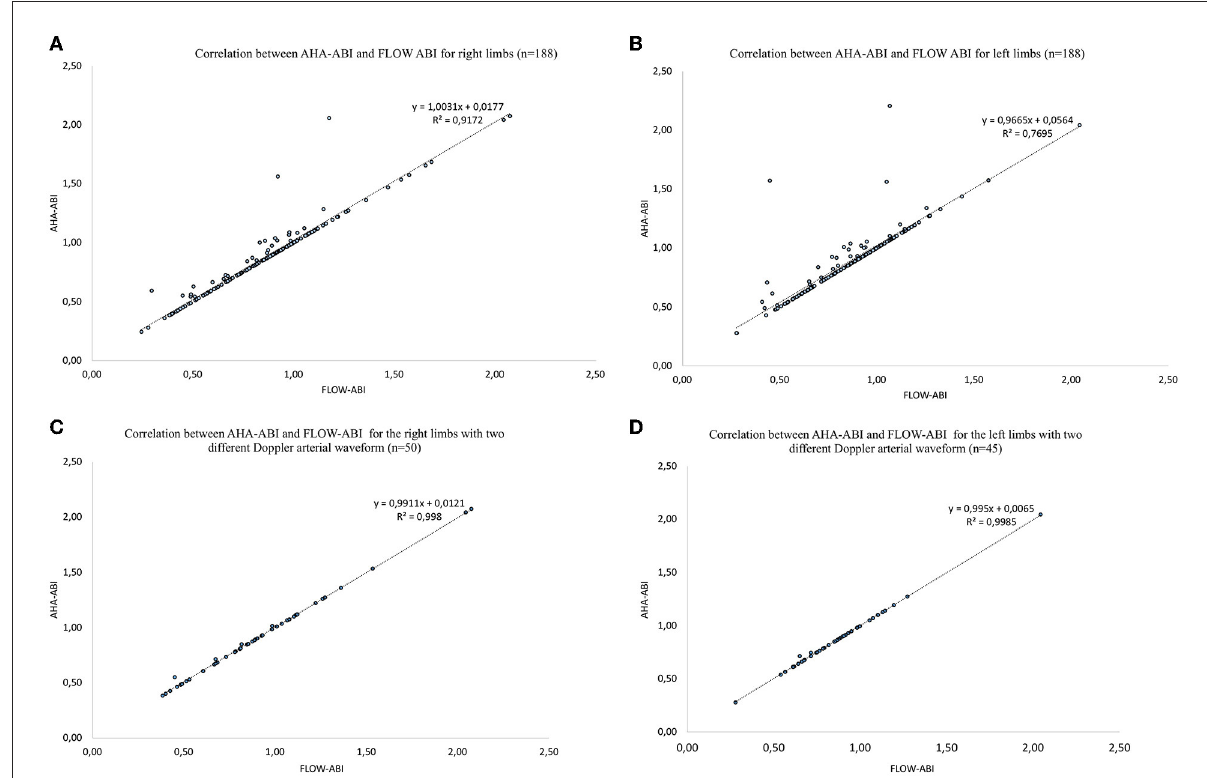
FIGURE3 Correlation plots for each lower extremity between AHA-ABI and FLOW-ABI. PAD means lower extremity peripheral artery disease. FLOW-ABI corresponds to the ABI calculated according to the best arterial flow. AHA-ABI corresponds to the ABI calculated according to the American Heart Association guidelines. (A) Relationship between AHA-ABI and FLOW-ABI for the right limbs. (B) Relationship between AHA-ABI and FLOW-ABI for the left limbs. (C) Relationship between AHA-ABI and FLOW-ABI for the right limbs with two different Doppler arterial waveforms. (D) Relationship between AHA-ABI and FLOW-ABI for the left limbs with two different Doppler arterial